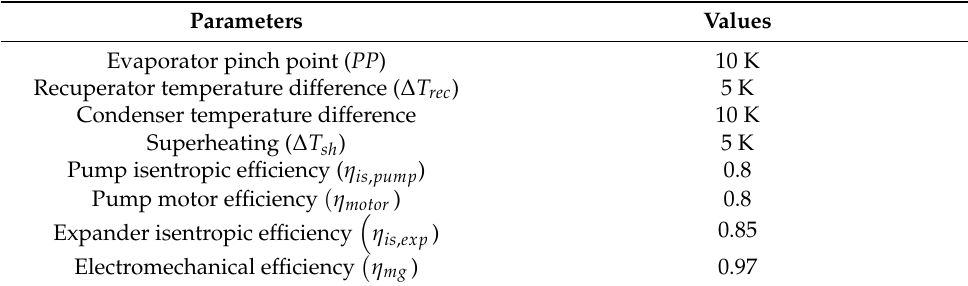
Table 1. Parameters of the